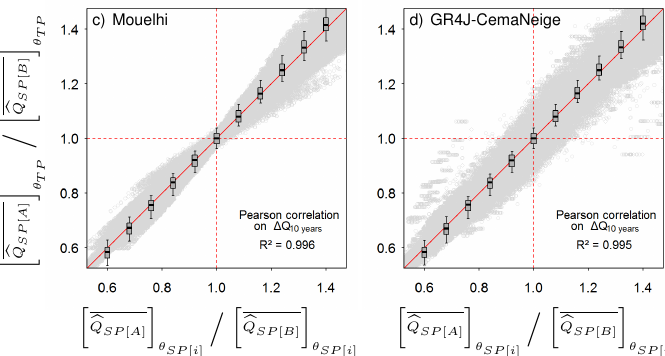
Fig. A3. Comparisons of relative changes in 10yr mean flow, observed and simulated (aggregation of results from 365 catchments, considering any possible pair of 10yr sub-periods A and B